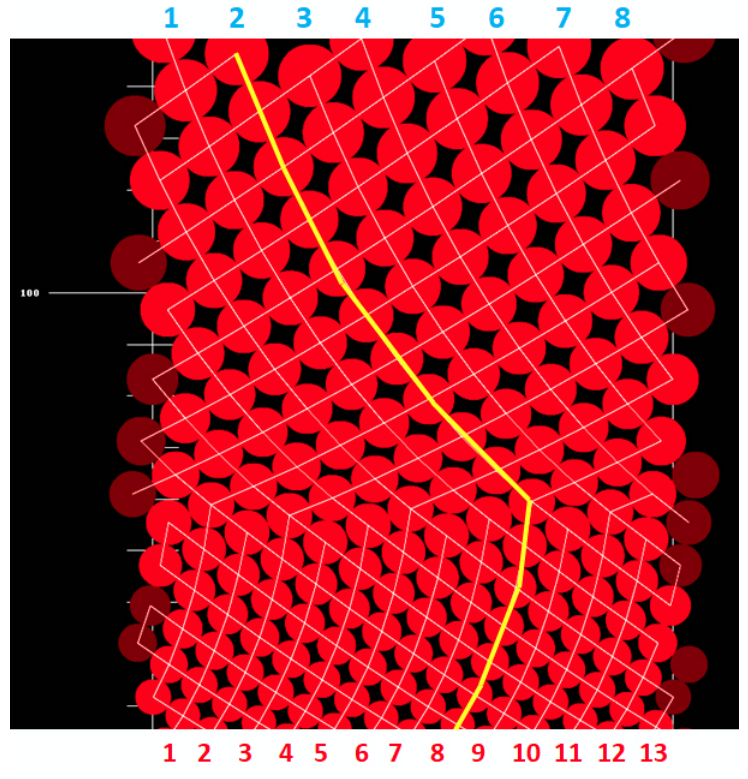
Figure 6 A computer simulation showing the effects of continuous increase in leaf primordia size (red circles) initiated within simulation space of constant width, which represents the size of shoot apical meristem’s organogenic zone (split open). White fine lines are the opposite parastichies connecting leaves along the shortest routes. The leaf traces make up the vascular sympodia (vascular parastichies) under two imperatives: to be the shortest and as vertical as possible. The initial 13 sympodia change into eight. In the lower part of the simulation, the connections between every eighth leaf are more horizontal than between every thirteenth leaf. In the upper part, suddenly the connections between every eighth leaf become shorter than between every thirteenth leaf. From that moment on, the number and orientation of sympodia change. The change in their orientation is marked with yellow line. Interface between the two domains of opposite sympodia orientation is